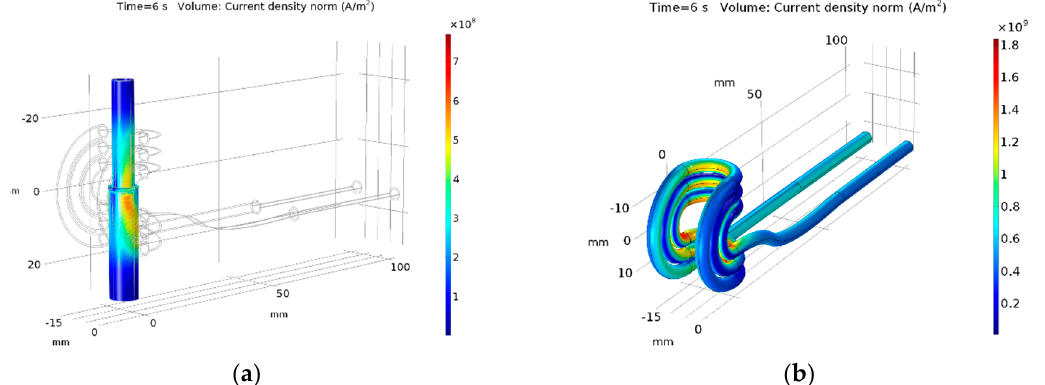
Figure 5. Current density (copper), ( a ) brazing assembly, ( b ) coil. Energies 2020 , 13 , x FOR PEER REVIEW